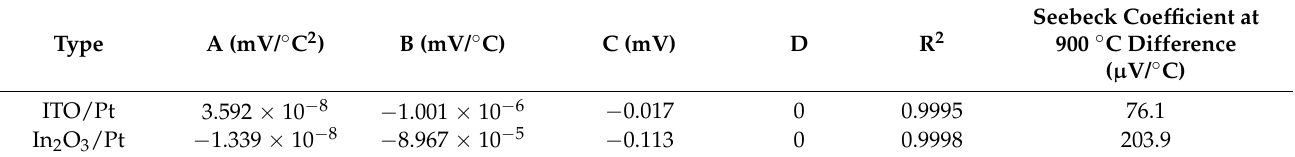
Table 1. Polynomial fitting results of ITO/Pt and In 2 O 3 /Pt thin film